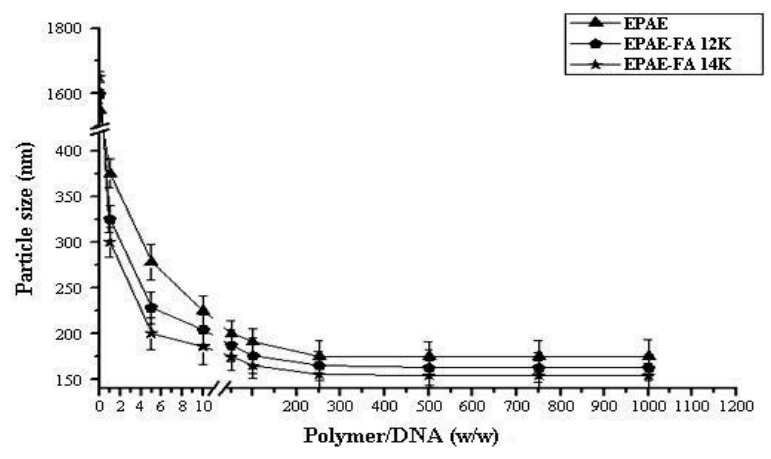
Figure 2. Sizes of EPAE/DNA and EPAE-FAs/DNA complexes prepared at various